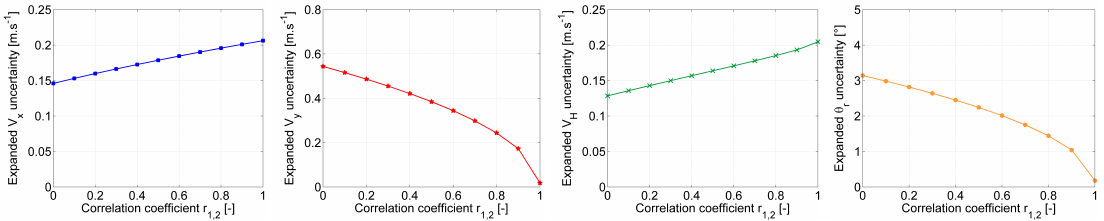
, U V , U V and U θ as a function of correlation coefficient r 1,2 x y H r